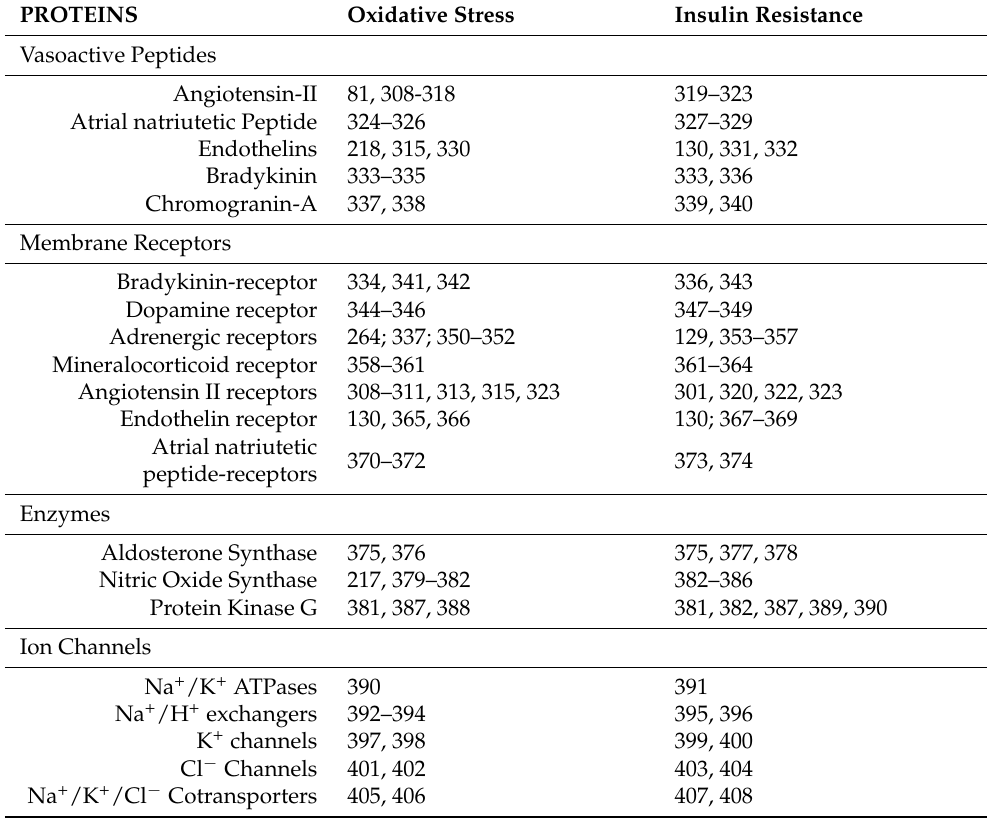
Table 1. Oxidative Stress and Insulin-resistance Linked Proteins in